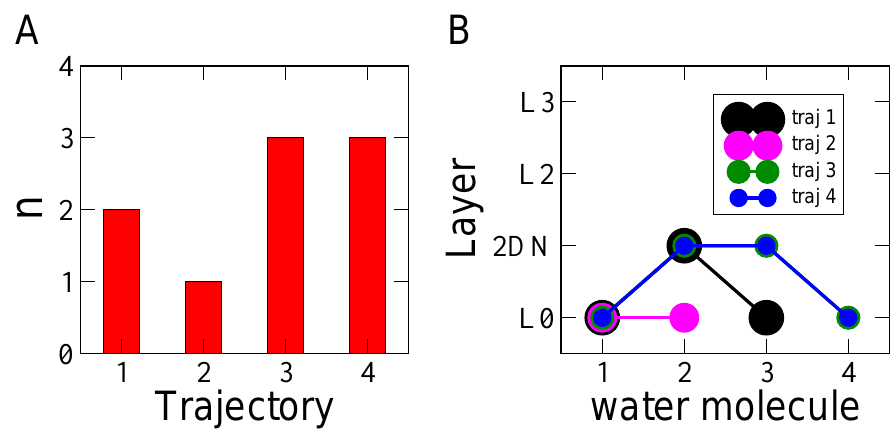
Figure 3. ( A ) Number of proton hopping events (n) observed for each of the four DFT-MD 25 ps trajectories. ( B ) for each trajectory, the proton hopping mechanism is illustrated by reporting the layer (L0–L3) to which each water molecule involved in the hopping belongs to. The label 1–4 on the x-axis refers to the sequence of